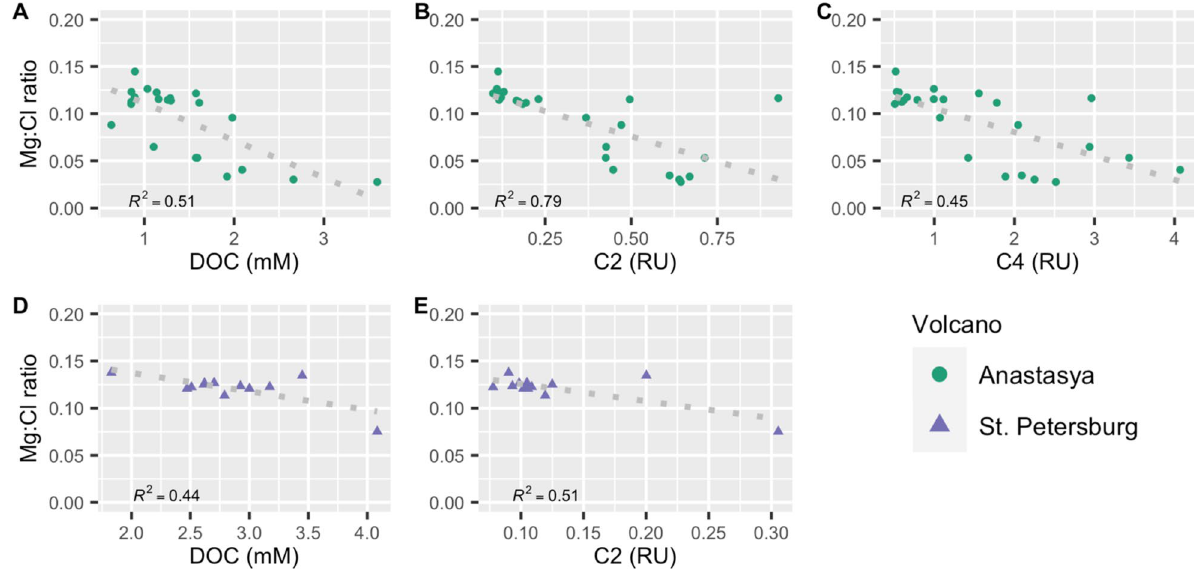
Figure 5. Linear relationship between the Mg:Cl ratio with dissolved organic carbon (DOC) and fluorescent components in Anastasya ( A – C ) and St. Petersburg ( D , E ). Only the relationships with p < 0.01 are shown.